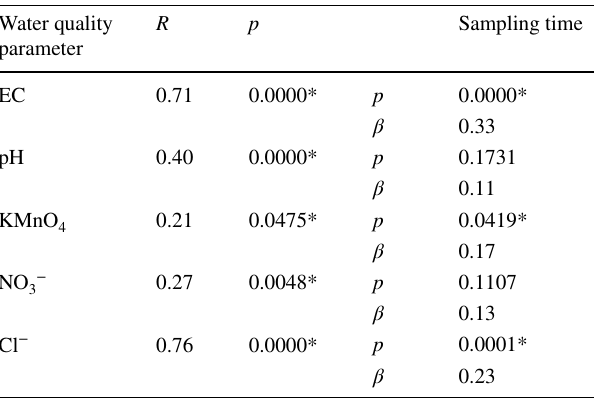
Table 3 Multiple regression analysis (MRA) testing—correlation among the physicochemical parameters and sampling